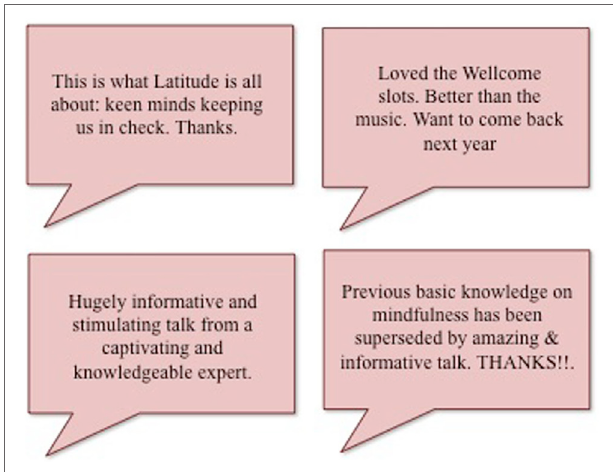
FigUre 2 | Examples of comments left on feedback cards, Latitude Festival (Grand,